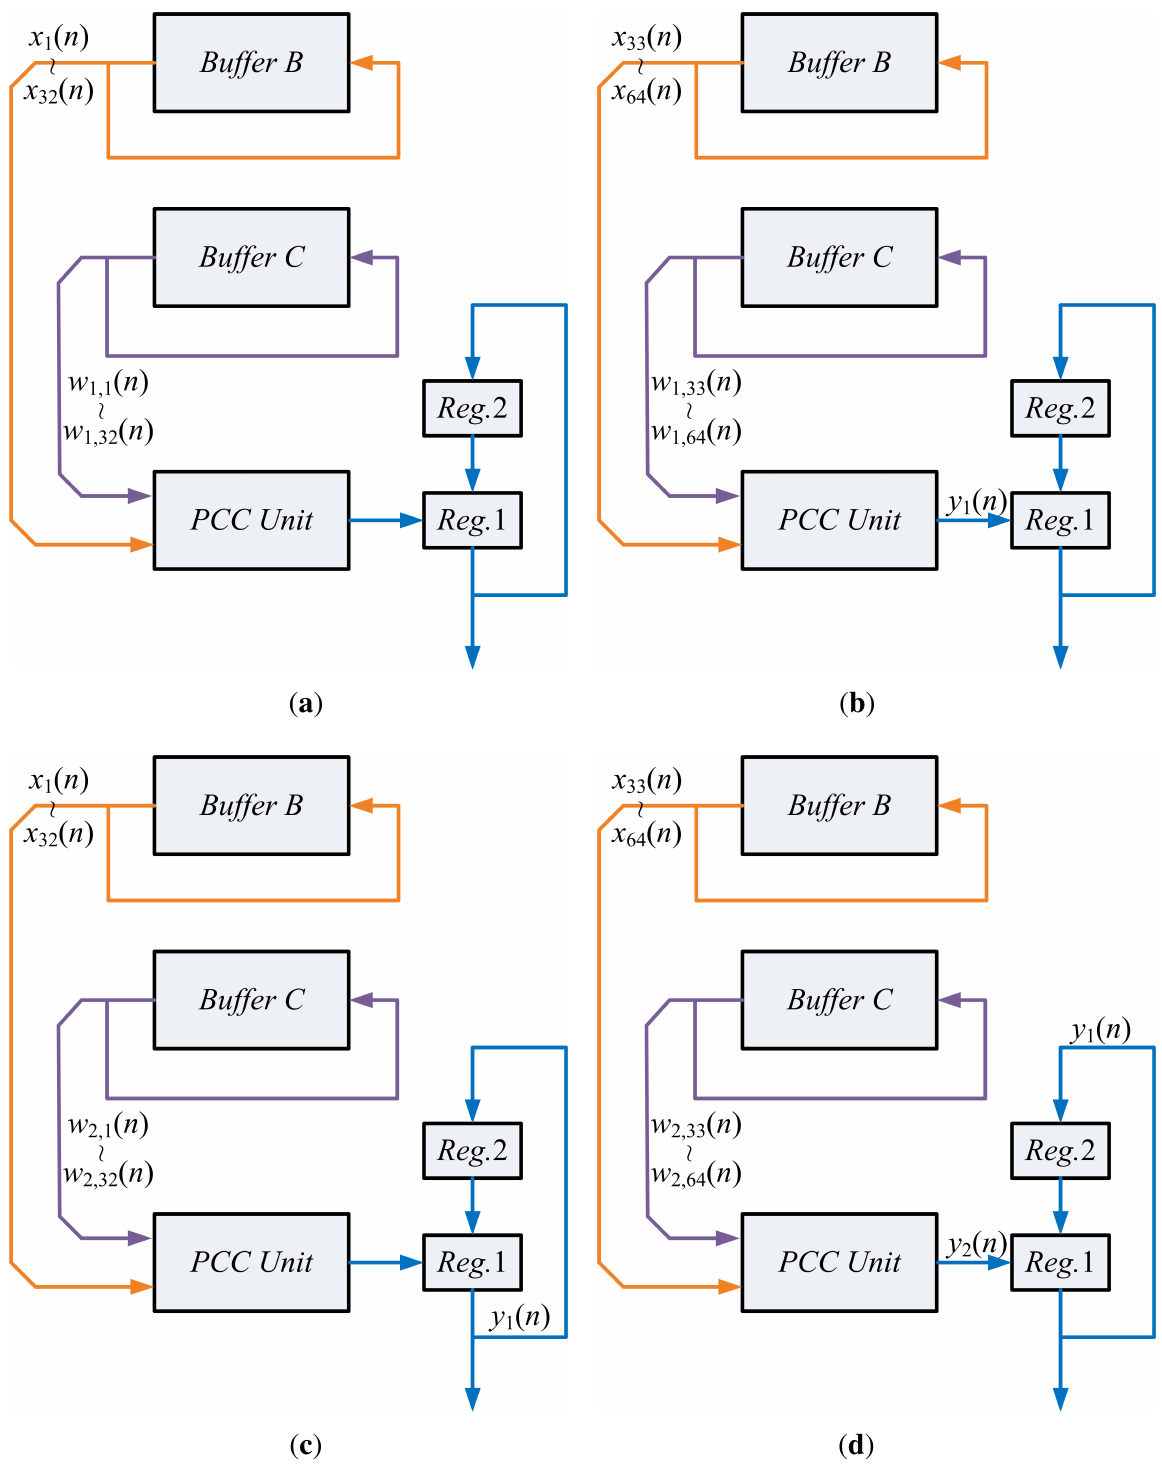
Figure 6. Operations of principal components computing (PCC) unit in State 3 of the GHA ( n ) ; ( b ) second step of computing y ( n ) ; ( c ) first step circuit: ( a ) first step of computing y 1 1 ( n ) ; ( d ) second step of computing y ( n ) of computing y 2 2